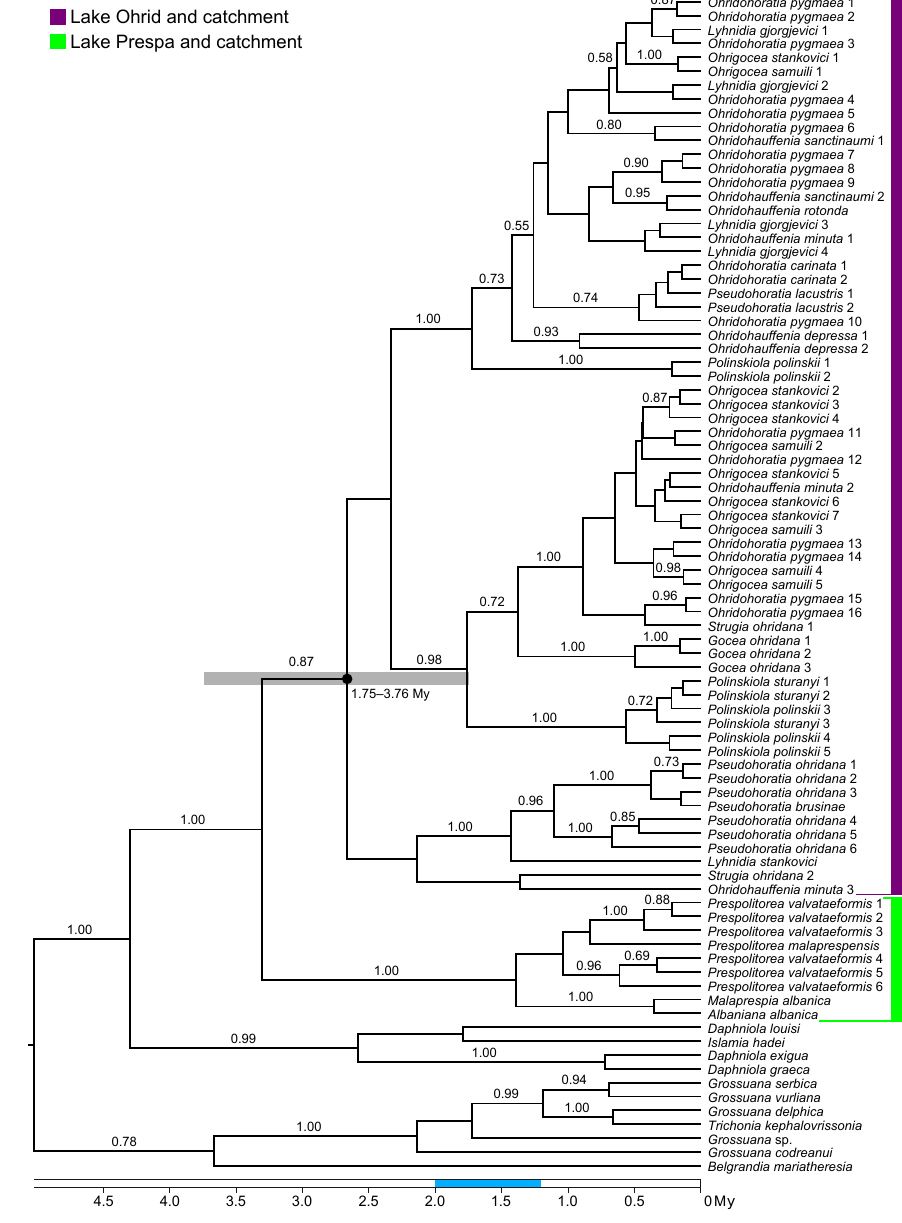
Figure 3. MCC tree based on a relaxed-clock BEAST analysis for non-pyrgulinid Hydrobiidae from the Balkans. Posterior probabilities > 0.5 are shown at the respective branches. The grey bar indicates the 95% HPD for the age of the MRCA of the Ohrid endemics. The blue bar in the timescale ranging from 1.2 to 2.0My shows the assumed age of Lake